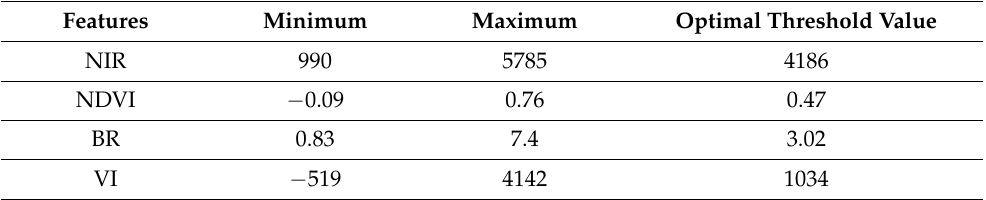
Table 5. The optimal threshold values for each feature on the basis of cross-validation method.